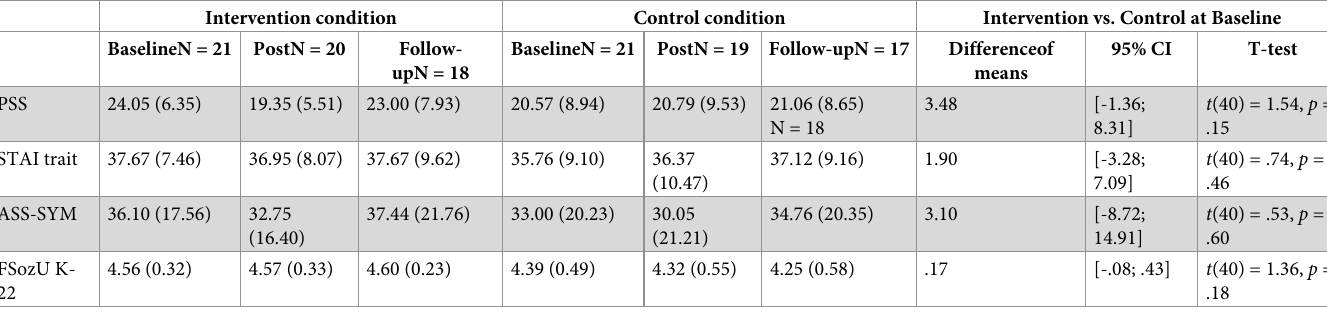
Table 1. Condition differences in psychological variables over the course of the study.